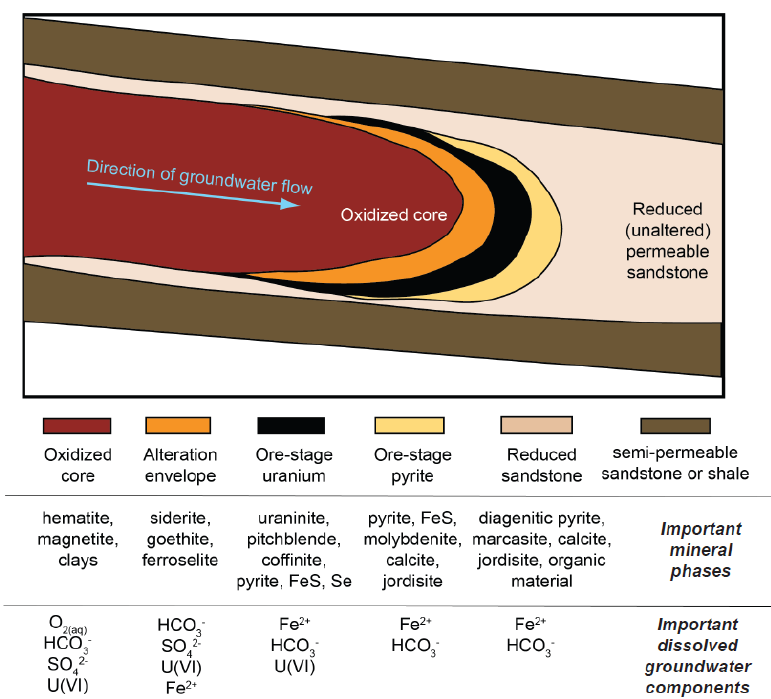
Figure 4. Simplified cross section of a uranium roll front showing the upgradient oxidized and downgradient reduced zones (modified from [18]).